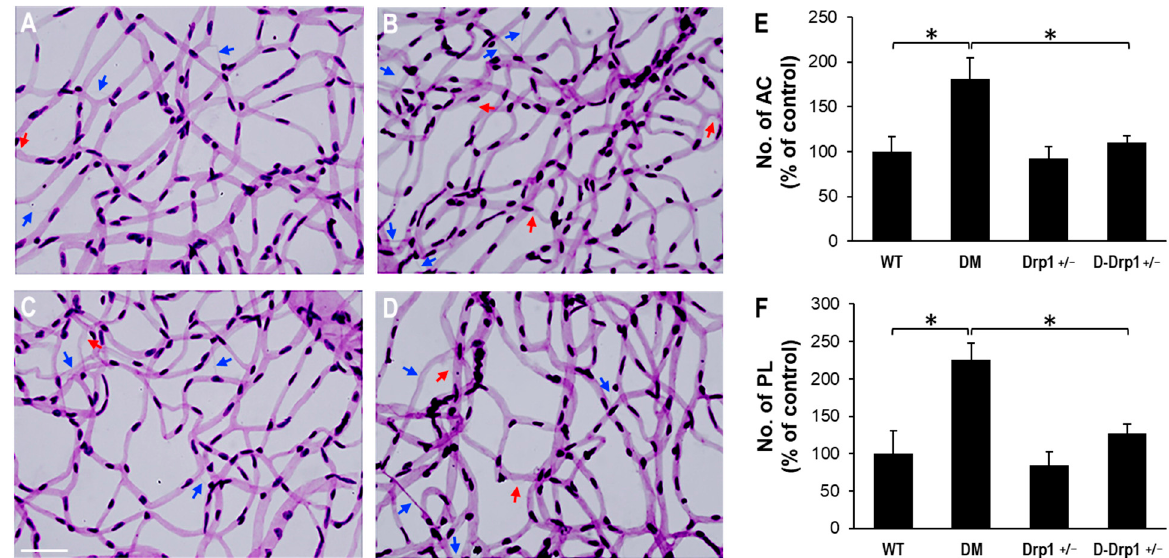
Figure 6. Effects of diabetes or decreased Drp1 level on AC and PL development in mouse retinas. ( A – D ) Representative images of retinal trypsin digestion of ( A ) WT, ( B ) DM, ( C ) Drp1 +/ − , and D-Drp1 +/ − mice show the number of AC (blue arrows) and PL (red arrows) is increased in the diabetic mouse retina compared to that of control mouse retina. Importantly, the number of AC and PL is decreased in the D-Drp1 +/ − mouse retina compared to that of diabetic mouse retina. Scale bar = 100 µ m. Graphical illustrations of cumulative data show that reduced DRP1 levels in the D-Drp1 +/ − mouse retina exhibited a protective effect against the development of ( E ) AC and ( F ) PL. Data are expressed as mean ± SD. * p < 0.01, n = 12.